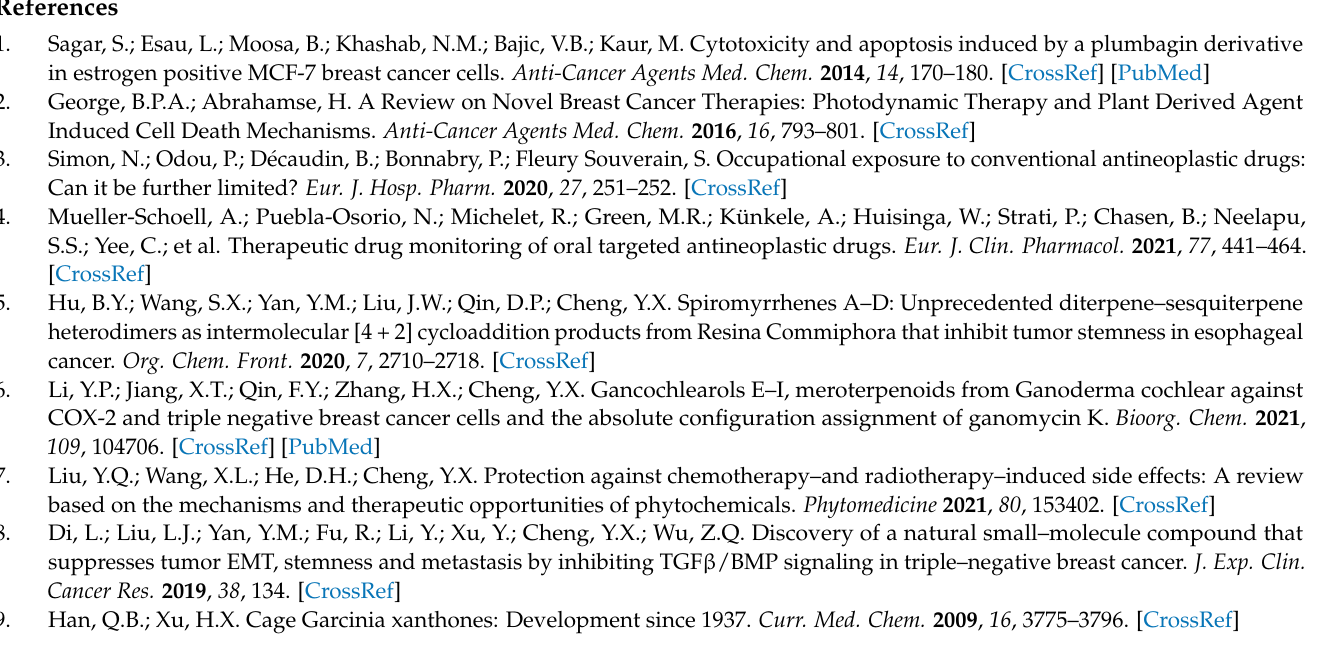
Figure S1–S30: the 1H NMR, 13C NMR and HRMS spectra of the compounds TH12-1 ~ TH12-10